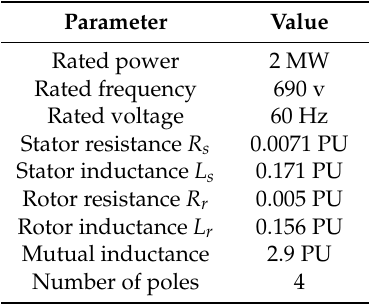
Figure 2. Schematic diagram of the wound rotor induction generator (WRIG). Table 2. Wound rotor induction generator (WRIG).wind turbine data.